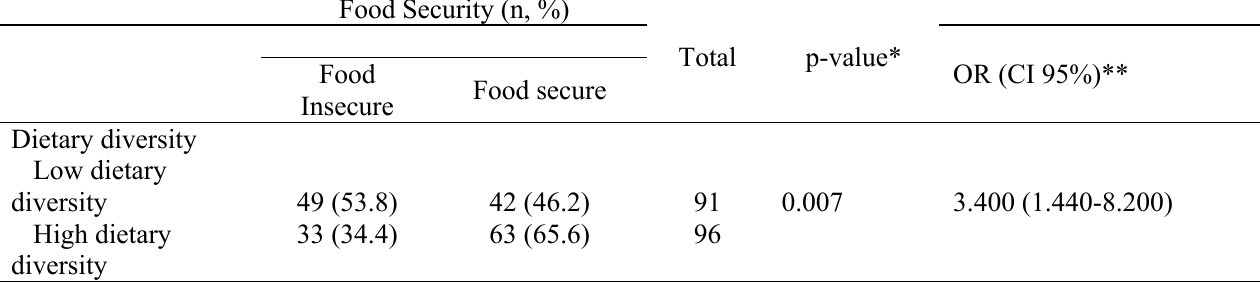
Table 3b. The association between social assistance and household food security (n=187)